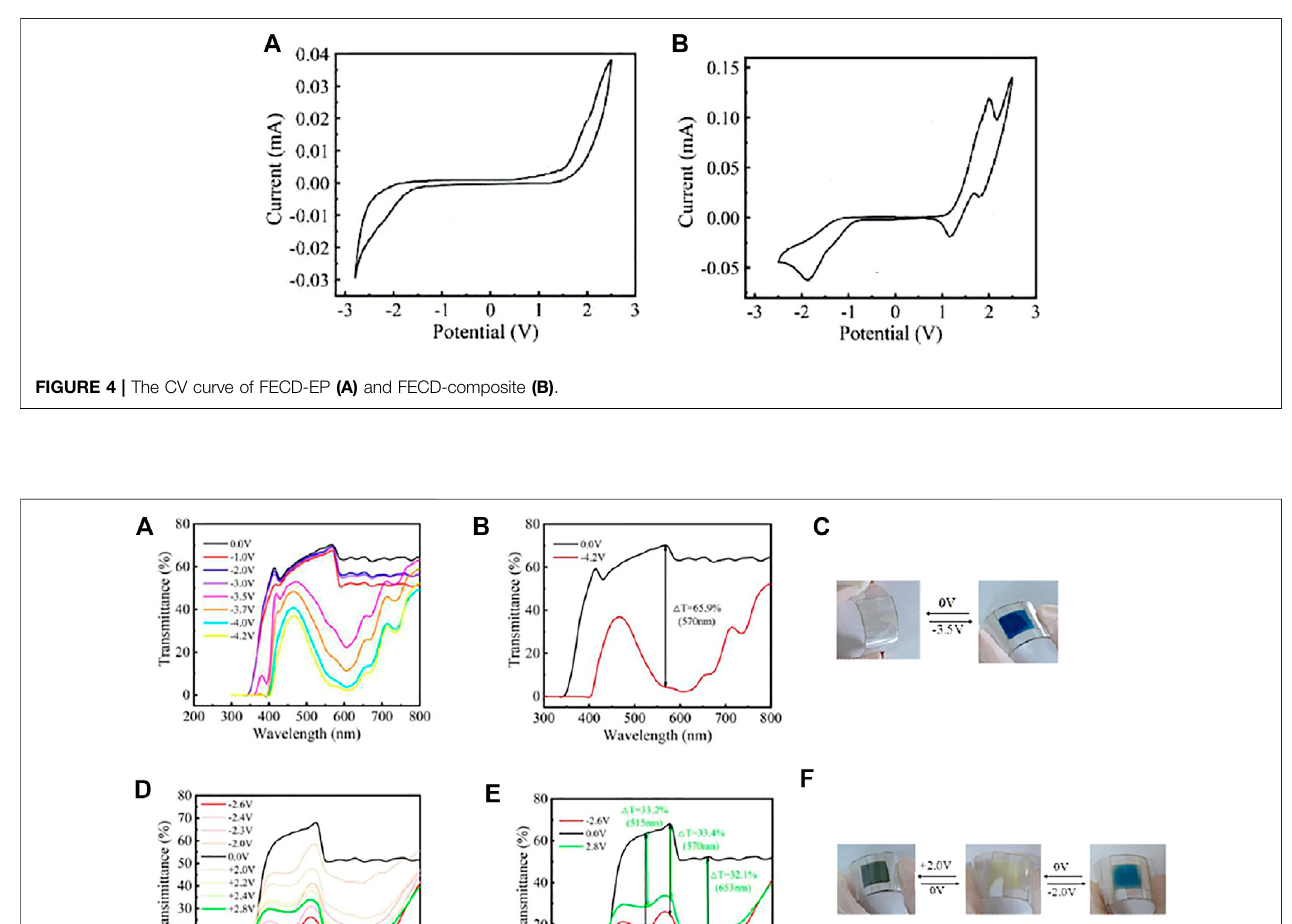
Frontiers in Nanotechnology |